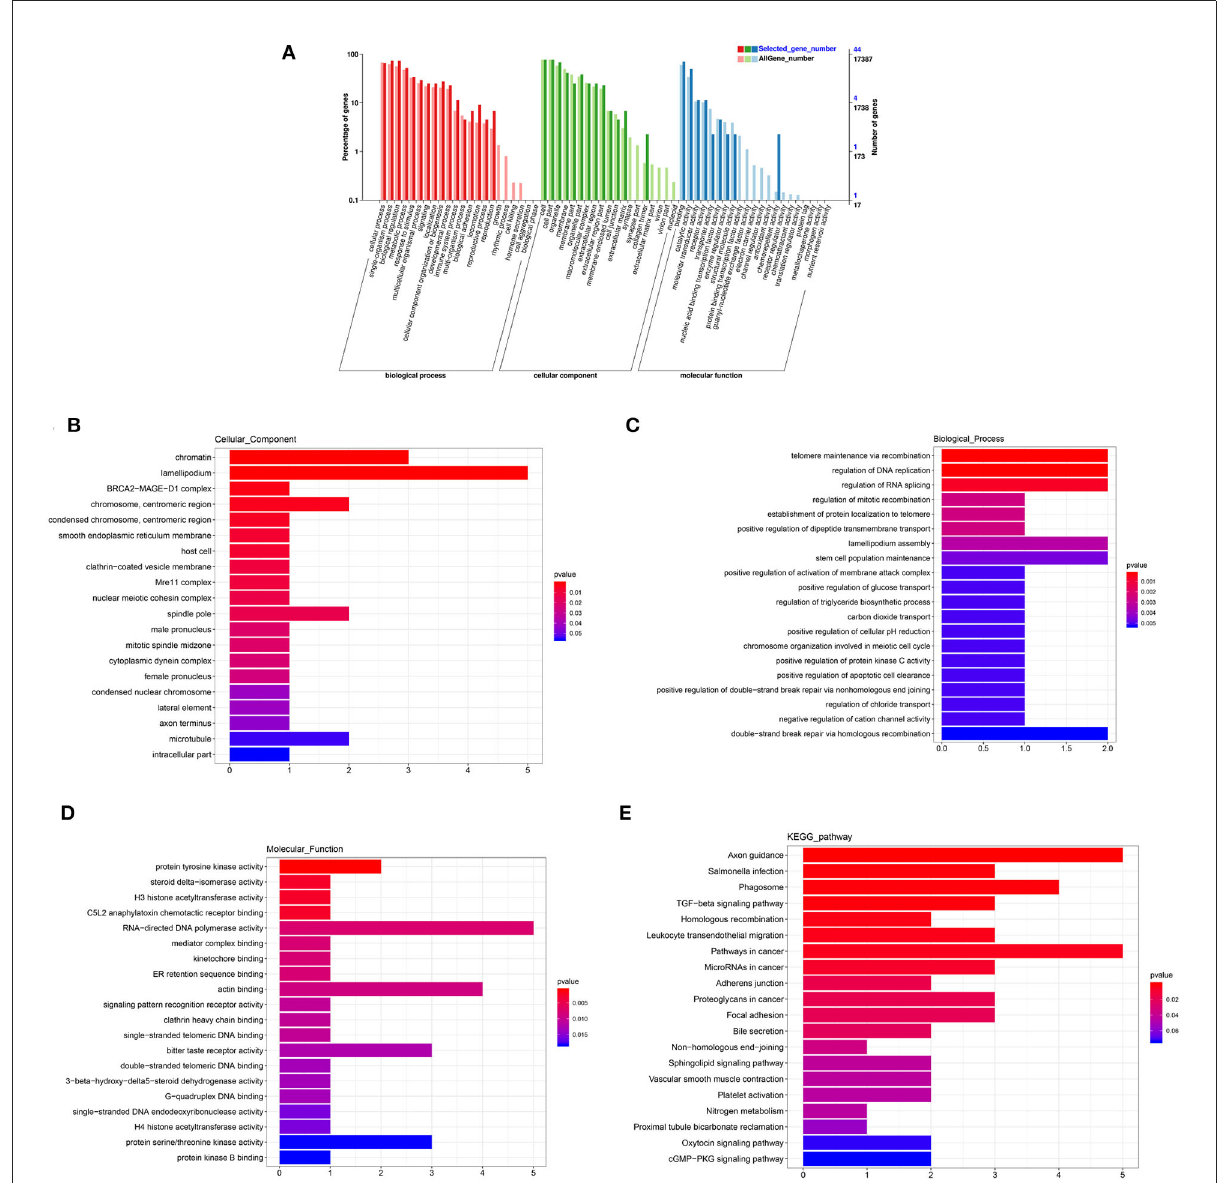
FIGURE5 GO and KEGG analysis of DEmRNAs. (A) GO enrichment of all mRNAs and DEmRNAs. (B) Cellular component enrichment. (C) Biological process enrichment. (D) Molecular function enrichment. (E) KEGG